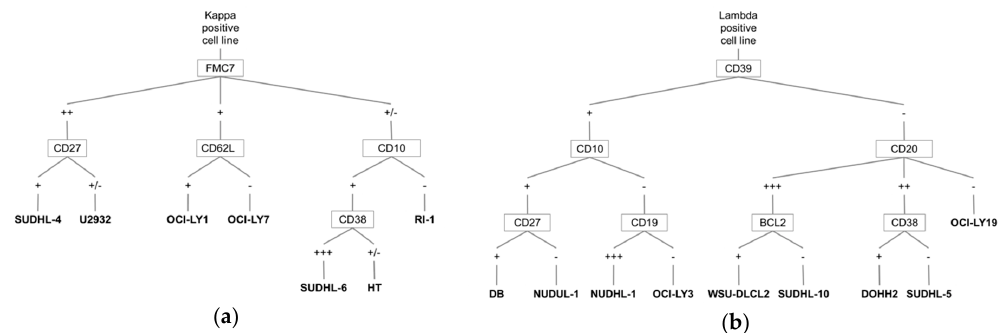
Figure 1. Algorithm for the identification of DLBCL derived-cell lines using multi-parameter flow cytometry. Diagram showing the identification strategy based on the mutually exclusive expression of the kappa ( a ) or lambda ( b ) light chain of immunoglobulins.